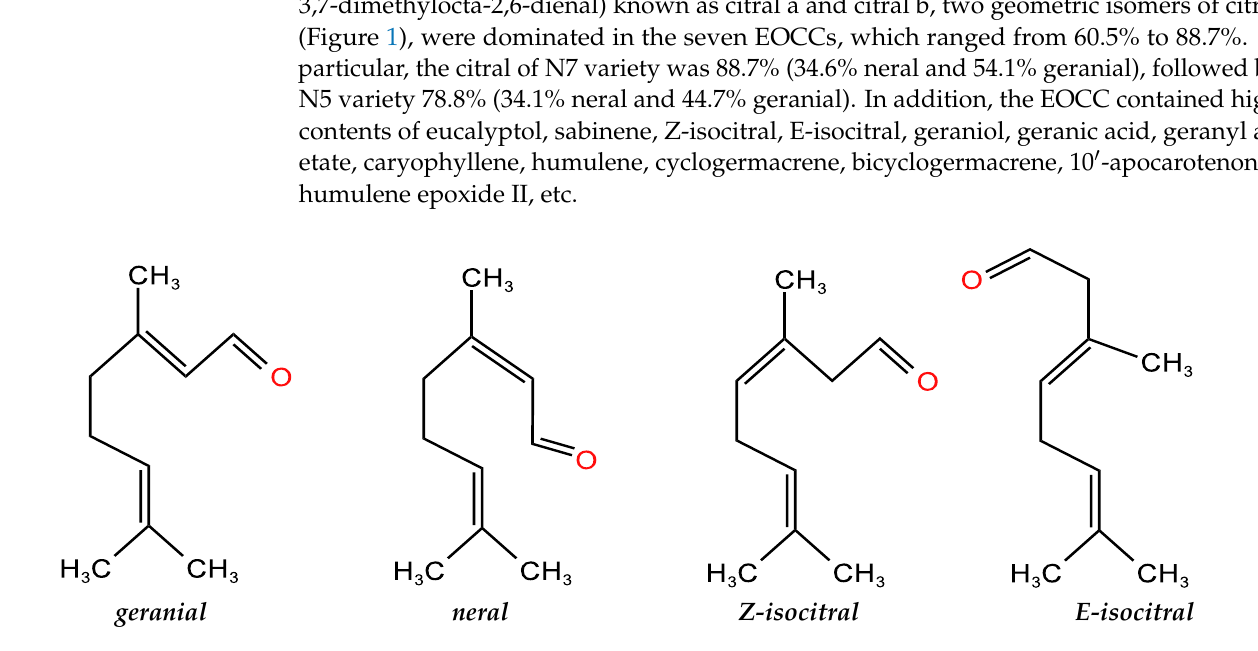
Figure 1. Chemical structures of the main compounds of the essential oils from citral chemotype C. camphora and C. bodinieri.